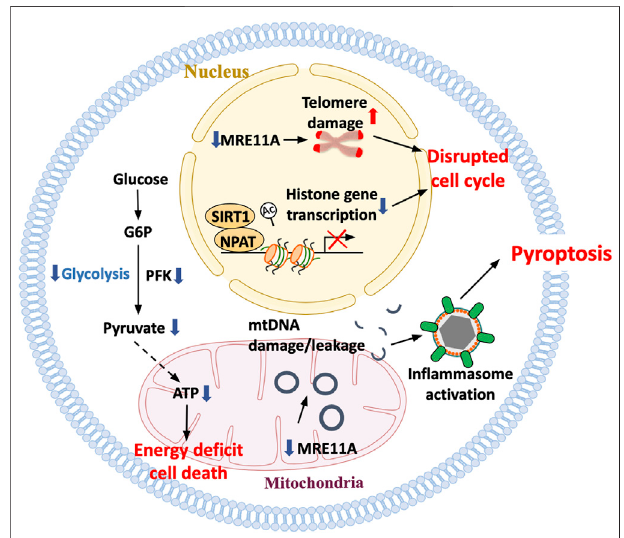
FIGURE 4 | Death pathways in aged T cells. With age, T cells are at increasing risk to die, aggravating the need for T cell replenishment but also exposing the tissue environment to an in fl ammatory nidus. Misregulation of histone production as well as accumulation of damaged telomeric ends have been implicated in disturbing proper cell cycle progression and inducing T-cell death. Mitochondrial insuf fi ciency serves as a major cause of lacking ATP production, depriving the cells of the bio-energy needed for survival. The inability of aging T cells to maintain stability of the mitochondrial genome has been mechanistically linked to the leakage of mtDNA into the cytosol, the activation of the in fl ammasome and the triggering of pyroptotic death. T cell pyroptosis purges T-cell reservoirs in lymph nodes and induces aggressive in fl ammation in peripheral tissues